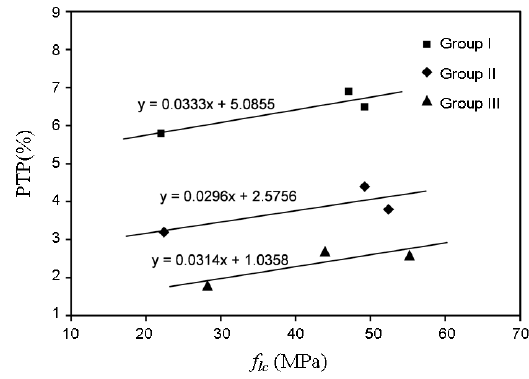
Fig. 8. Influence of concrete strength on the PTP